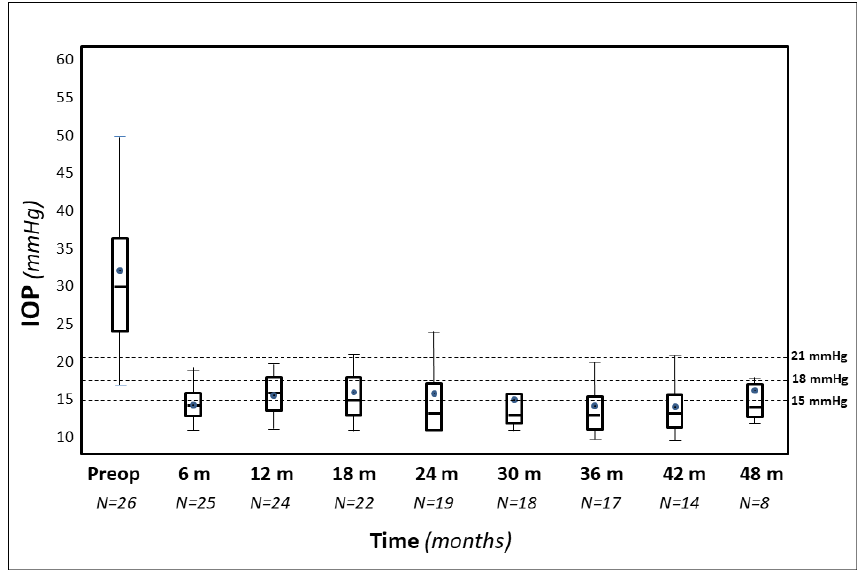
Figure 1. Box-plot representation of intraocular pressure (IOP) values over four years of follow-up. After 1, 2, 3, and 4 years, the mean IOP was 15.9 ± 4.0, 14.4 ± 7.3, 14.1 ± 2.1, and 15.7 ± 6.8 mmHg, respectively, with 0.4, 0.5, 0.6, and 1.1 medications, respectively (Figure 2).